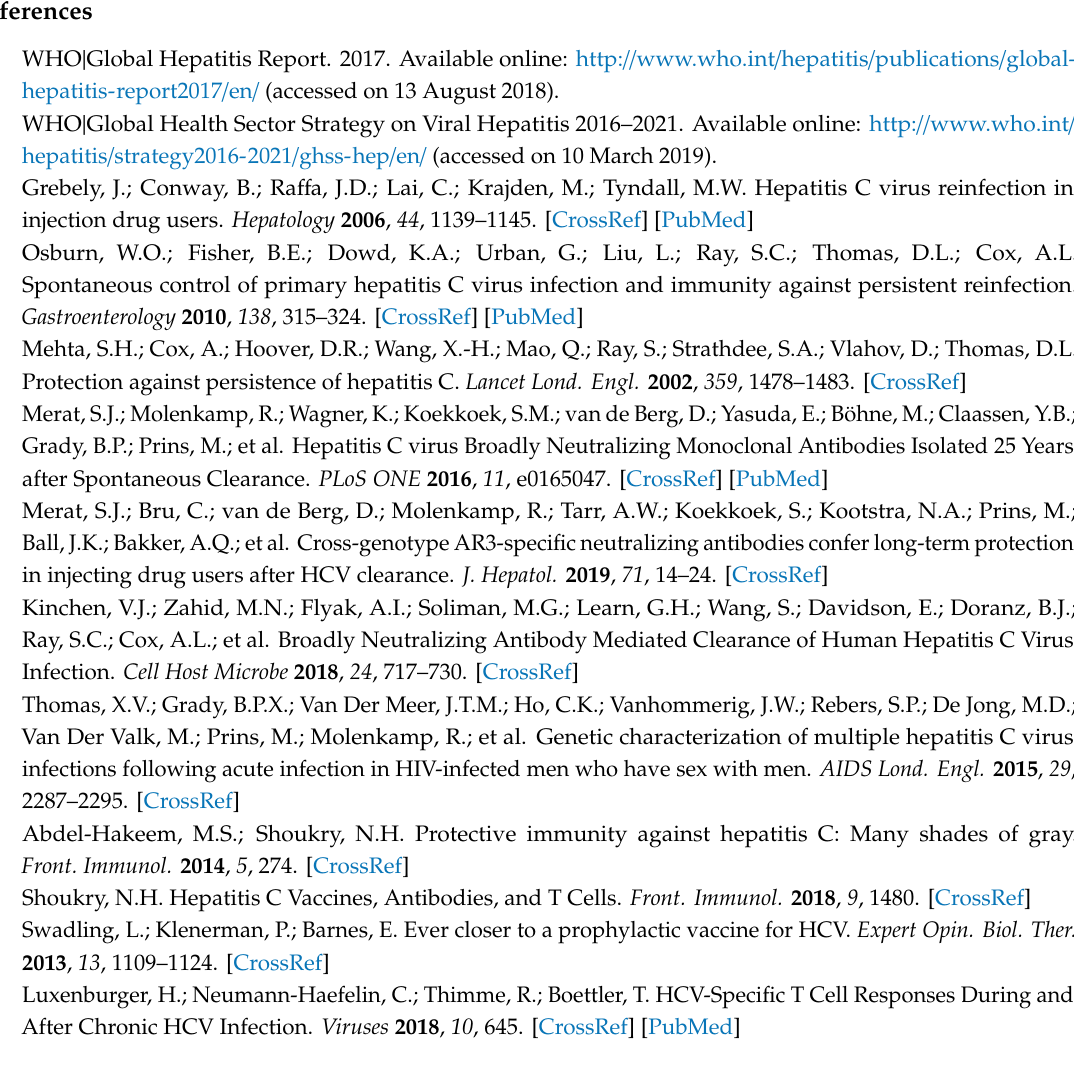
Figure S1: Unedited and non-cropped Western Blot, Figure S2: Unedited and non-cropped Coomassie